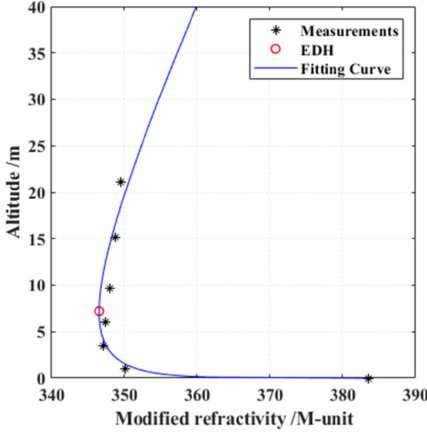
Figure 3. The calculating method of the EDH.